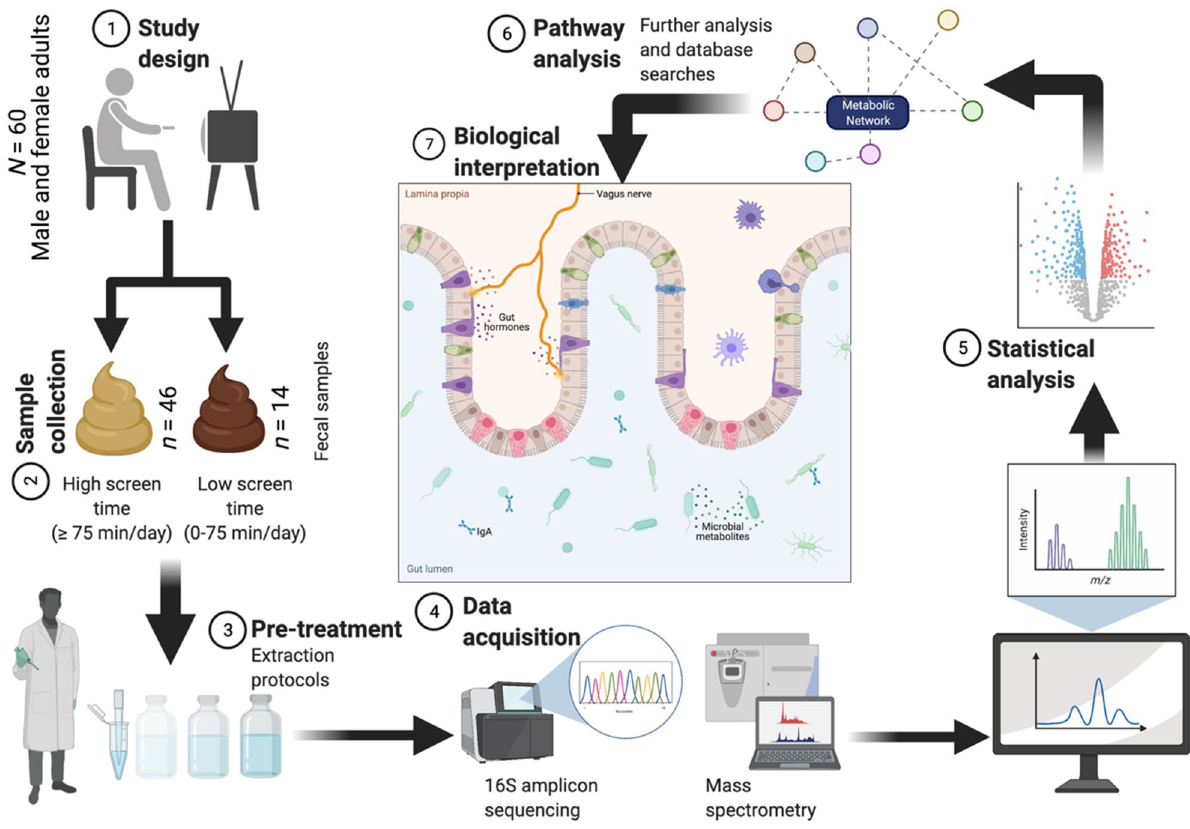
Figure 1. Overview of analytical workflow from study design to biological interpretation. Created with BioRender.com.